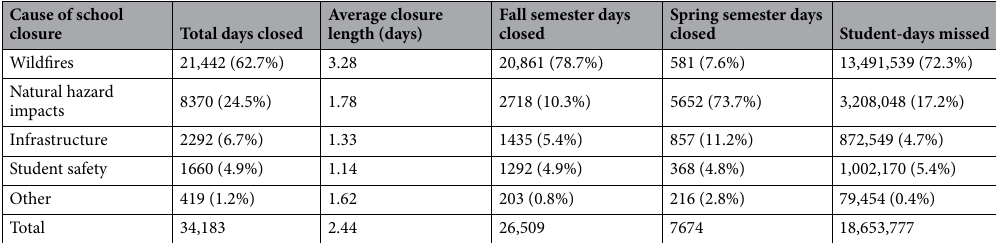
Table 1. School closure data by cause between the 2002–2003 and 2018–2019 academic